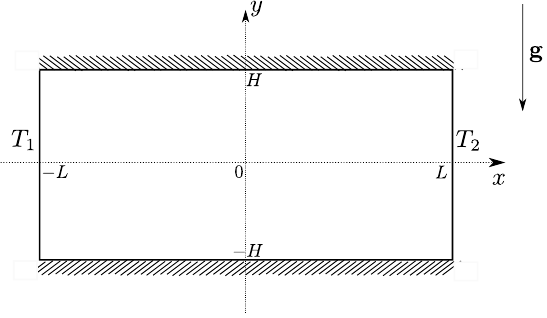
Figure 1. Sketch of the rectangular cavity with side heating discussed in Section